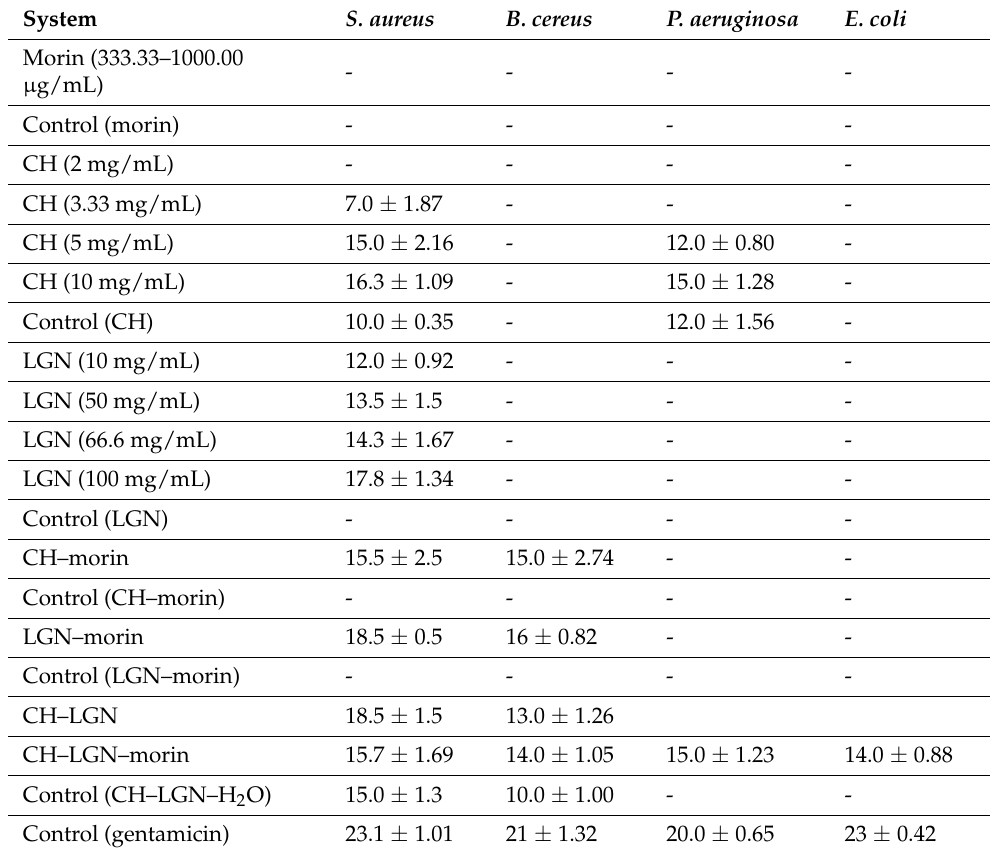
Table 1. Antimicrobial activity of the studied single-, two- and three-component systems and the respective negative and positive controls against the four microbial strains detected by measuring the inhibition zone (IZ,